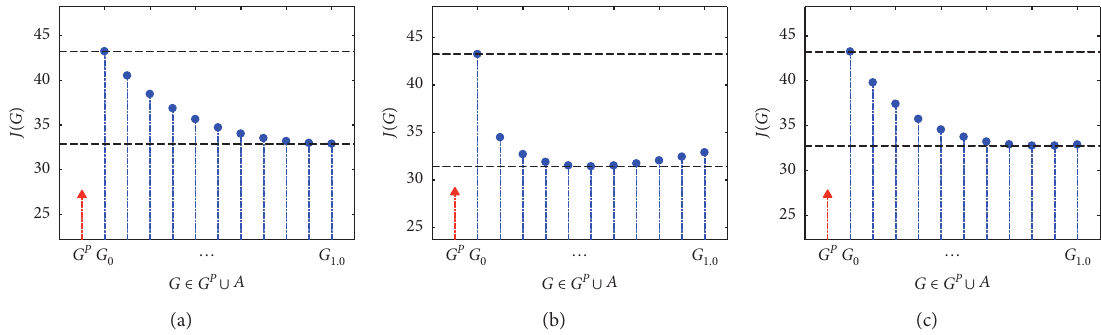
Figure 5: A comparison between the three promising controls G P in Figure 2 and the set of static controls A in terms of total